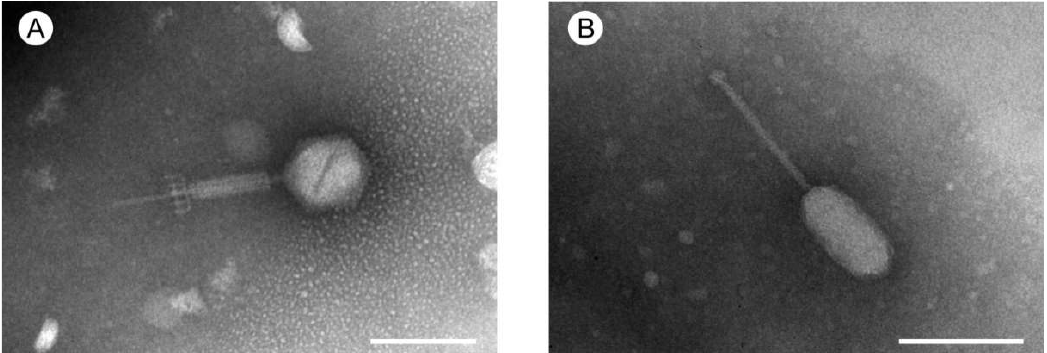
Figure 2. Morphology of the bacteriophages as revealed by transmission electron microscopy. ( A ) Enterococcus phage GVEsP-1. ( B ) Enterococcus phage SSsP-1. Scale bars = 100 nm.